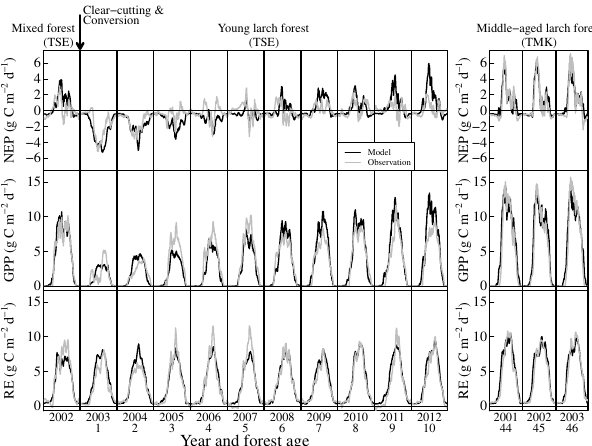
Figure 1. Seasonal and interannual variations in net ecosystem pro- duction (NEP), gross primary production (GPP), and ecosystem res- piration (RE) at the Teshio (TSE) and Tomakomai (TMK) sites. Black lines, output of the VISIT model; grey lines, observed val- ues. A 2-week moving window was applied to the daily values of the model and